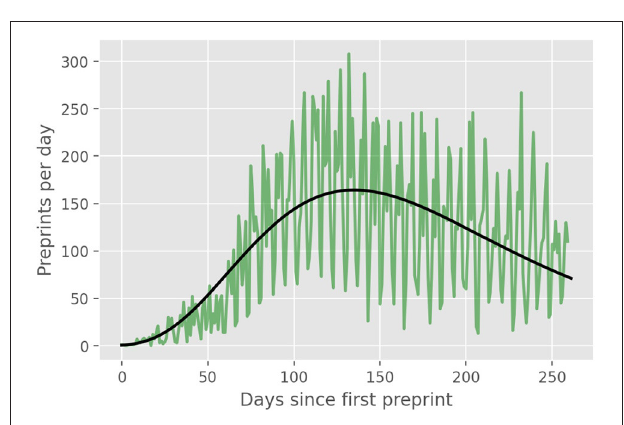
FIGURE 2 | Daily number (green line) of COVID-19 preprints posted on online preprint repositories up to September, 30, 2020. The solid black line is the derivative of the theoretical cumulative curve shown in Figure 1